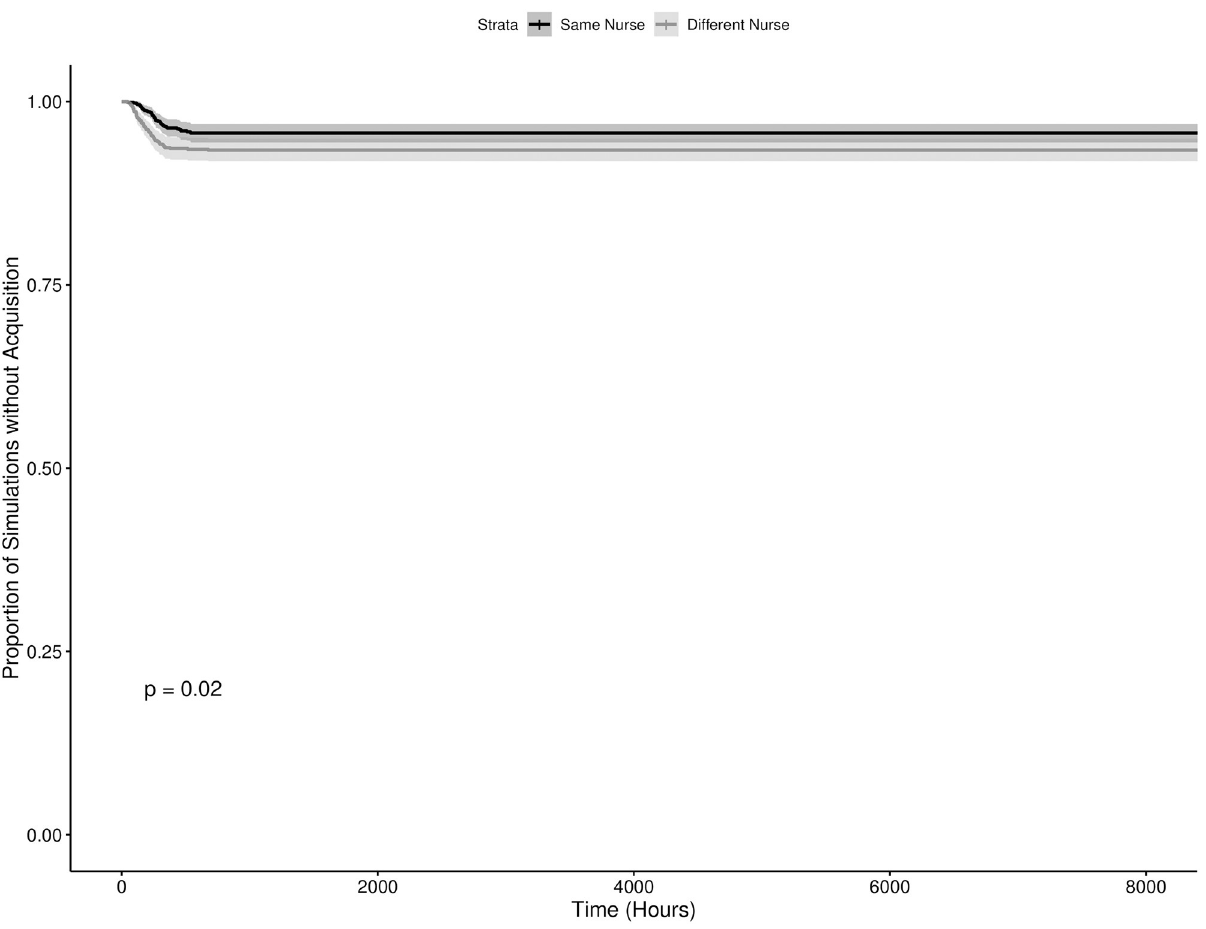
Fig 6. Time to third MRSA acquisition in an ICU meta-population model with no colonized admissionss. Time to Third MRSA Acquisition in an ICU Meta-population Model with No Colonized Admissions. The dark and light grey lines indicate starting conditions where two initially colonized patients are cared for by the same and different nurses respectively, with the shaded regions representing the corresponding 95% confidence intervals.